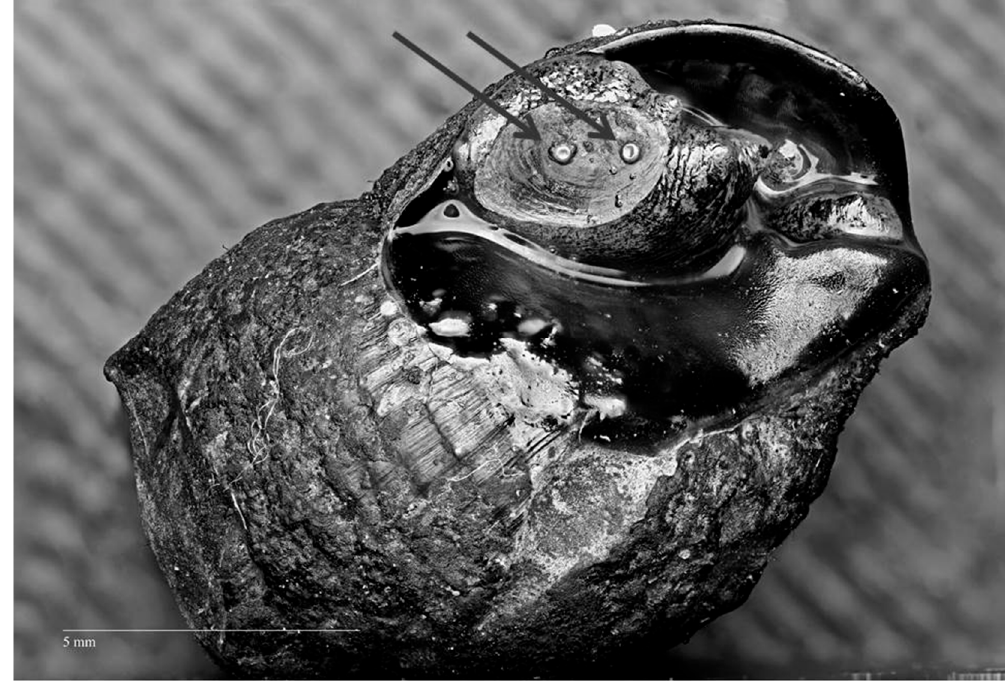
Figure 2. Photograph of mud snail ( Tritia obsoleta ) with arrows pointing to two cysts of the trematode parasite Pleurogonius malaclemys. Photograph taken by Dr. Russell Burke.